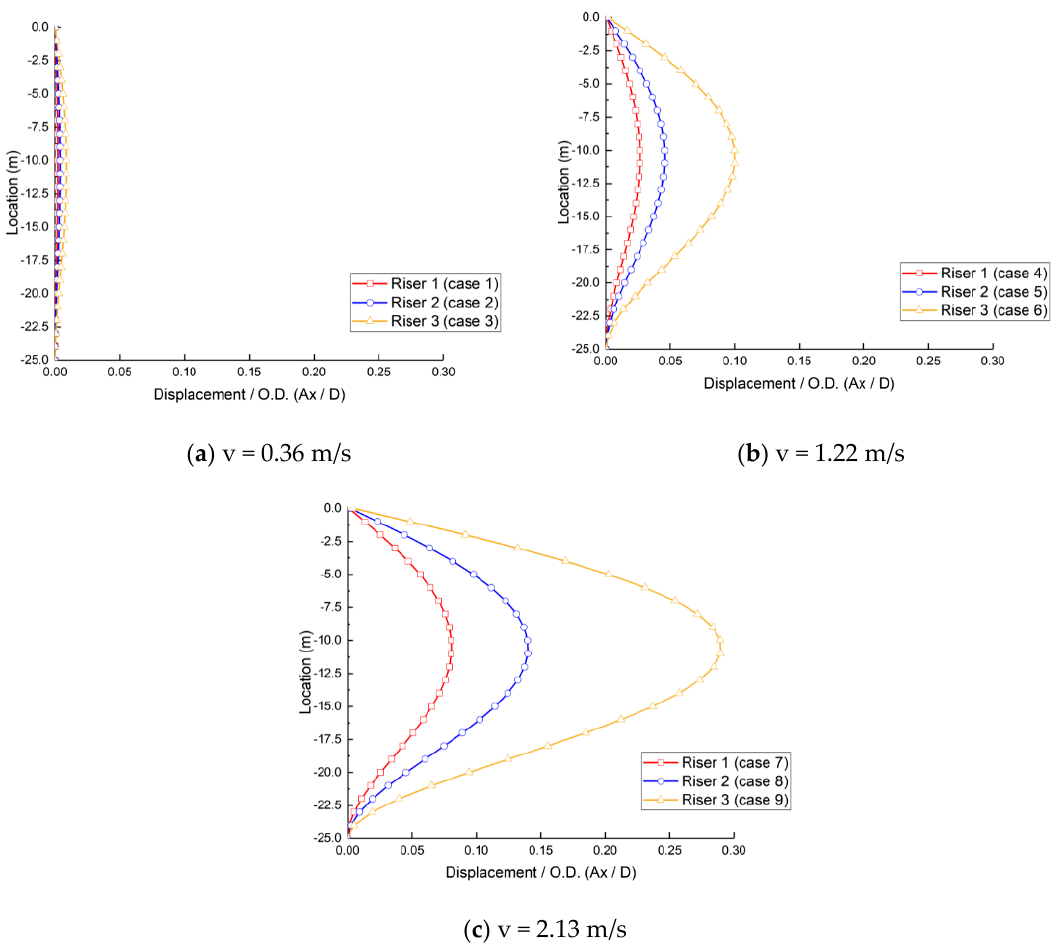
Figure 8. Maximum displacements/outside diameter (Ax/D) in in ‐ line flow direction (X) of all three risers.